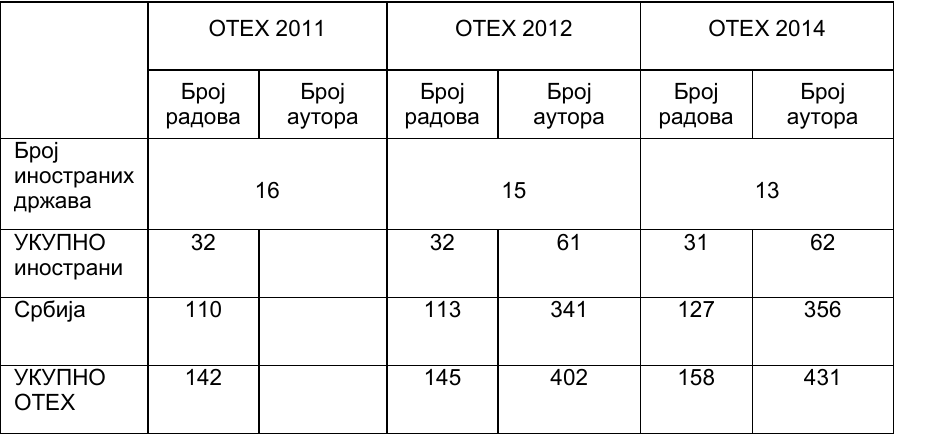
Table 4 – Overview of the number of papers and authors/coauthors by member states Таблица 4 – Обзор количества работ и авторов / соавторов по странам